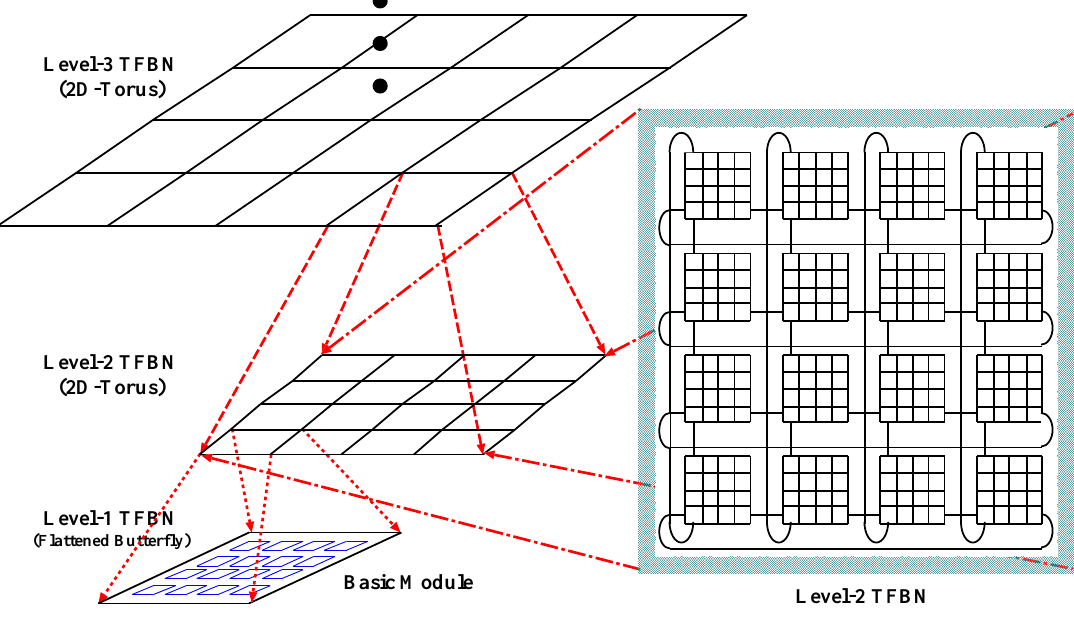
Figure 2. 4 × 4 higher level network of a